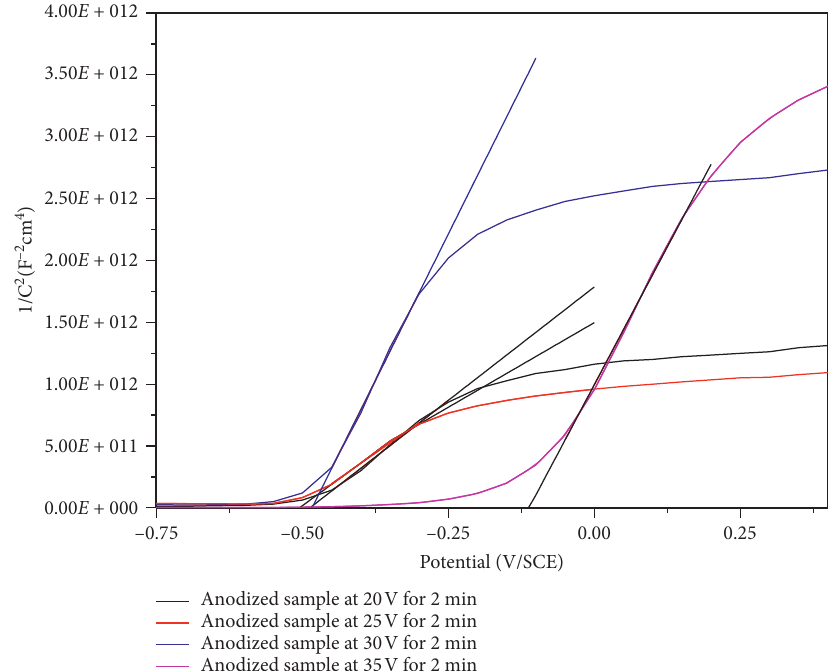
Figure 15: Mott–Schottky curve obtained at 1KHz, in 0.1M of Na